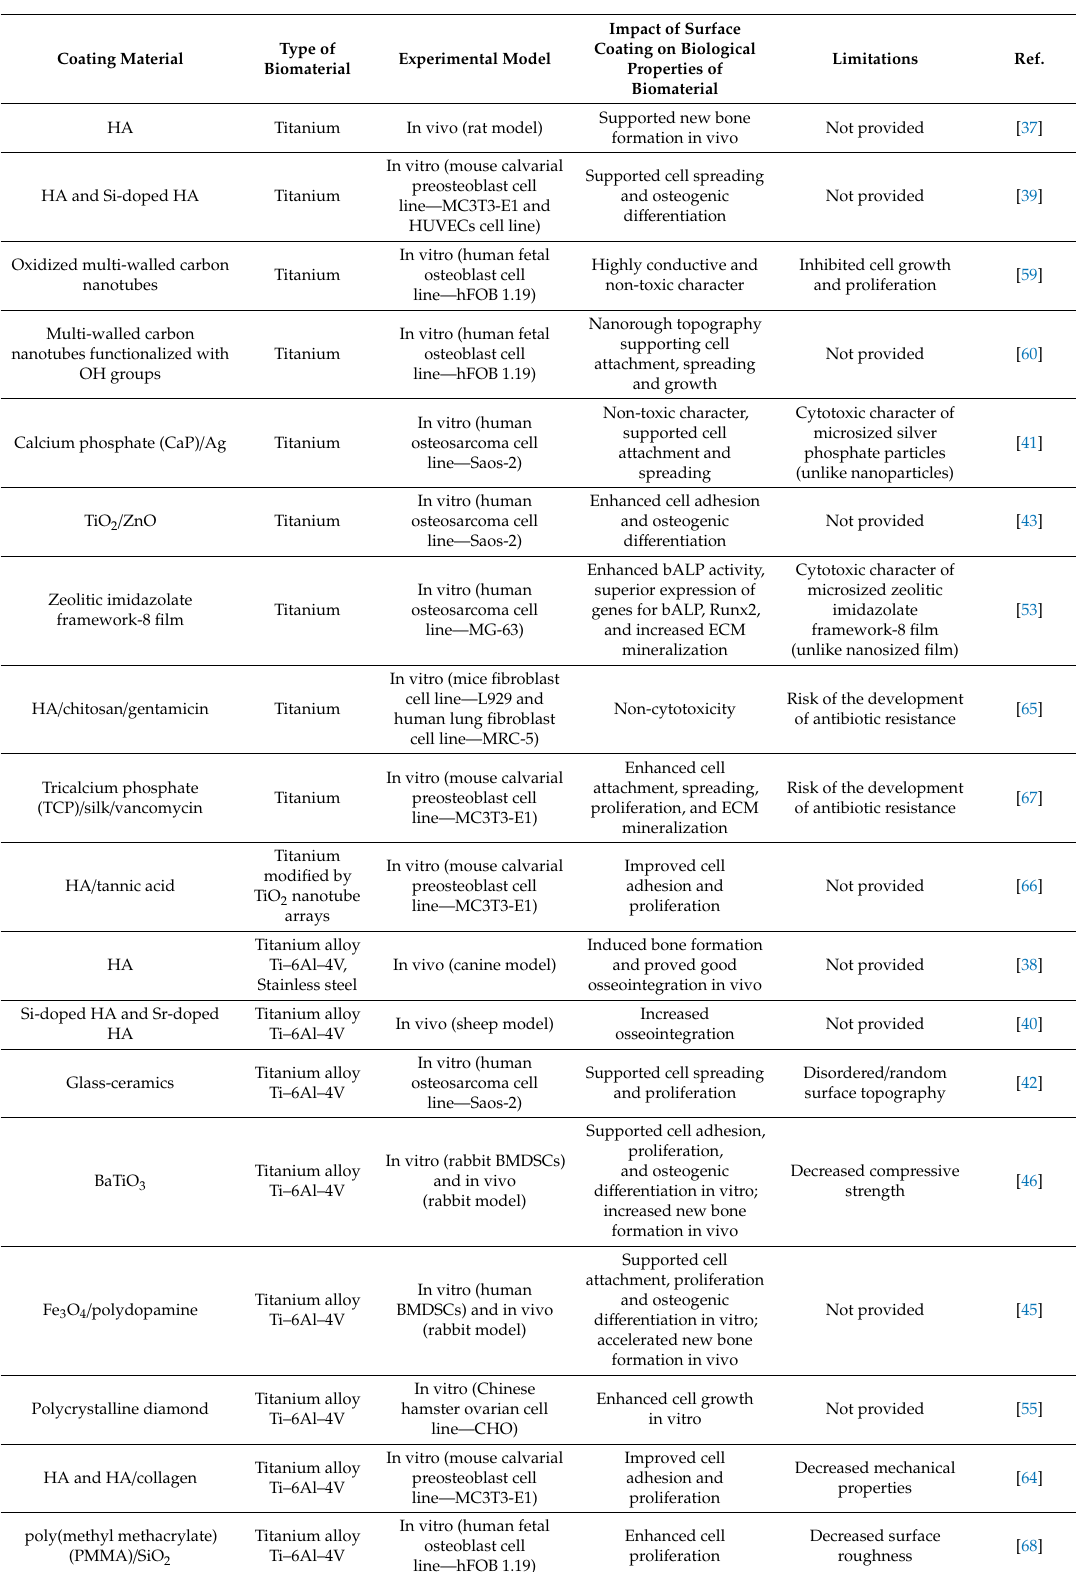
Table 1. Surface modifications of bone implants using inorganic and composite